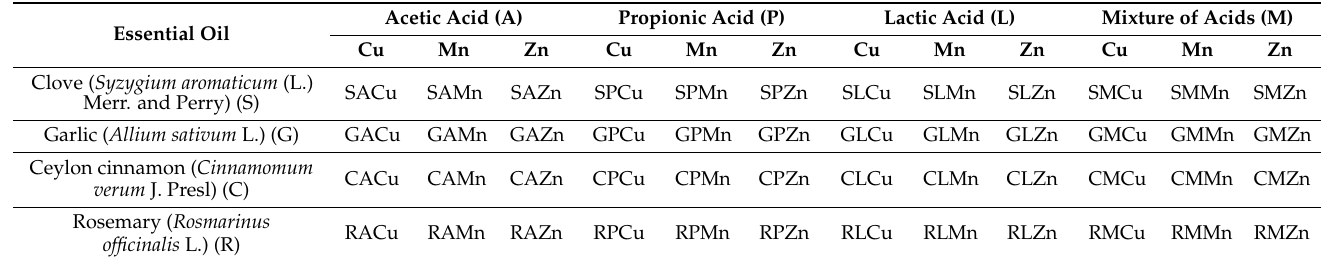
Table 1. Combinations obtained during the